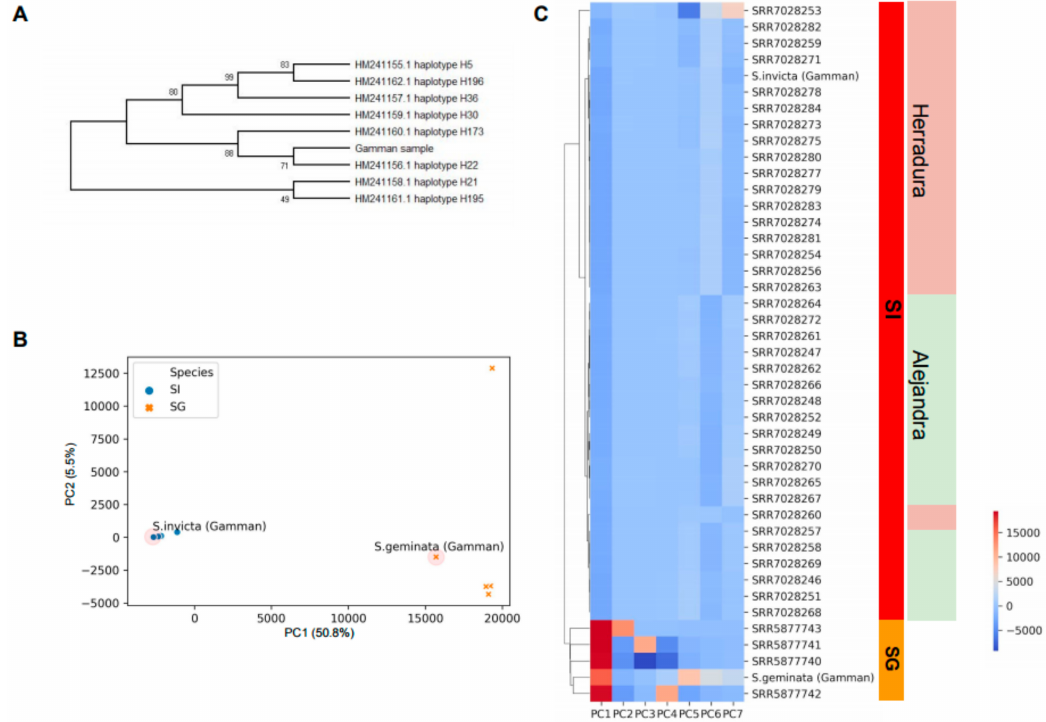
Figure 2. Identification of Gamman pier samples by the genomic data. ( A ) COX1 haplotyping to determine the origin of S. invicta sampled at Gamman pier. The numeric values on the nodes of the tree are the percentage of the reproduced partitions from the 1000 bootstrap replicates. ( B ) The 2D score plot of the principal component analysis (PCA) analysis with NCBI-deposited Solenopsis samples. ( C ) Heatmap using seven PCA scores together with the sampling